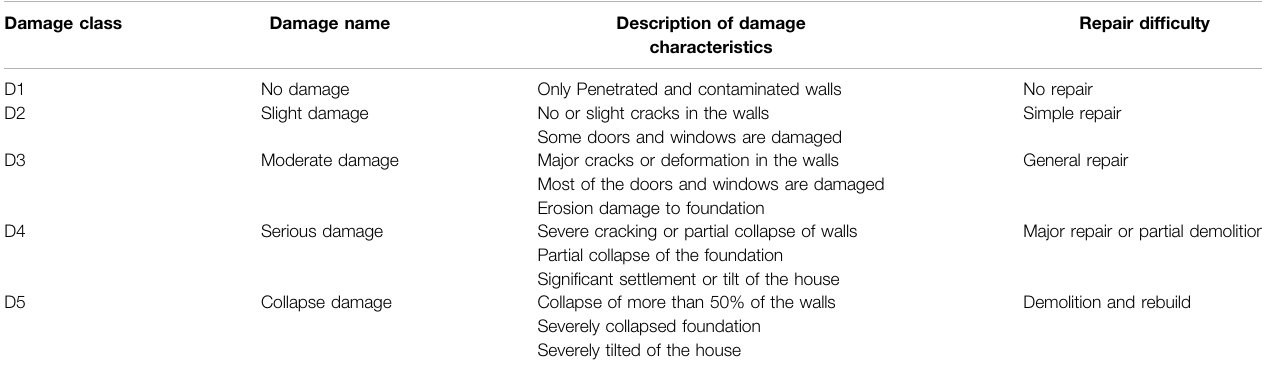
TABLE 7 | Classi fi cation of mountain torrent damage to building (Zhen et al., 2022). Damage